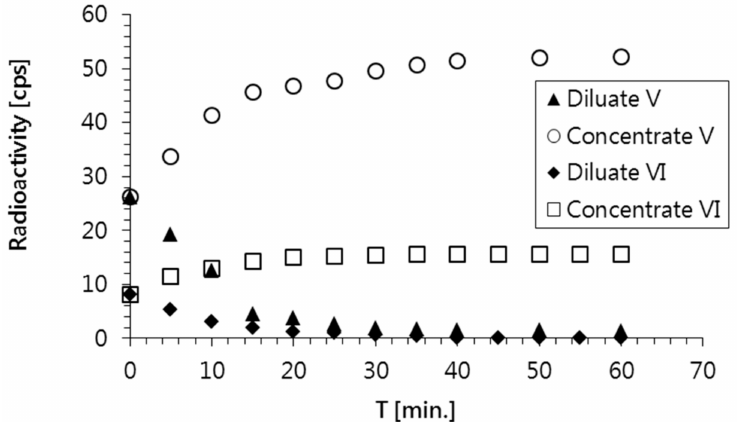
Figure 4. Changes in the radioactivity of the diluate and concentrate streams during the electrodialy- sis treatment of solutions No. V and VI.